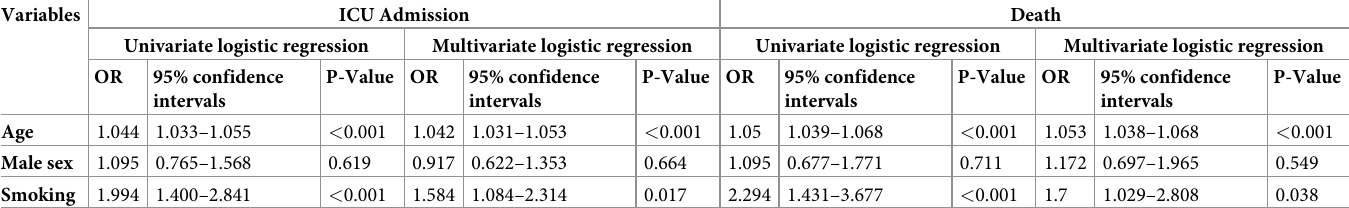
Table 2. Univariate and multivariate logistic regression demonstrating odds ratio (OR) for death and ICU admission among hospitalized COVID-19 patients (n = 743). OR = odd ratio. Variables